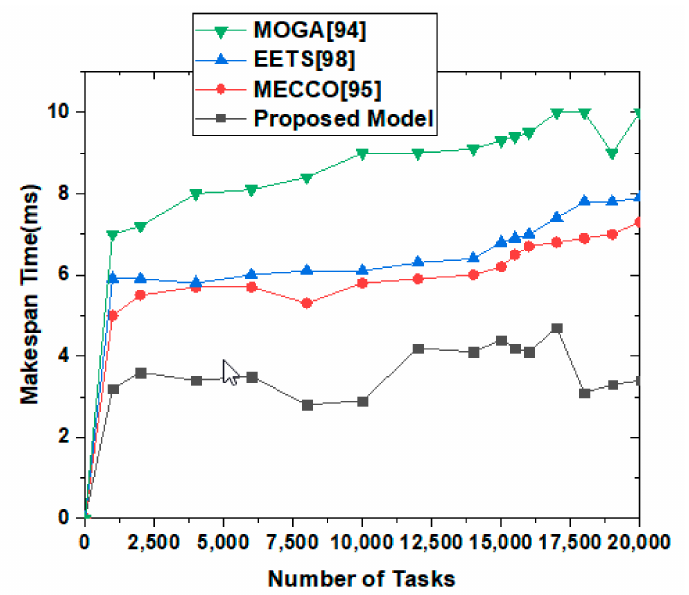
Figure 9. Time for request completion.